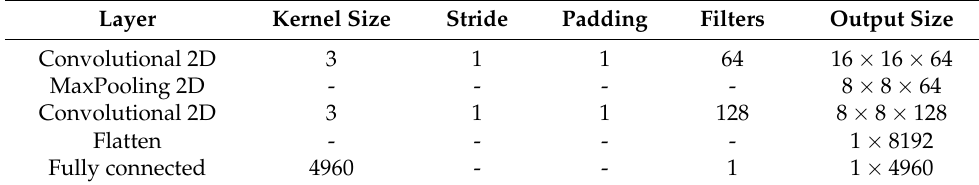
Table 8. Two convolutional layers SNN (model